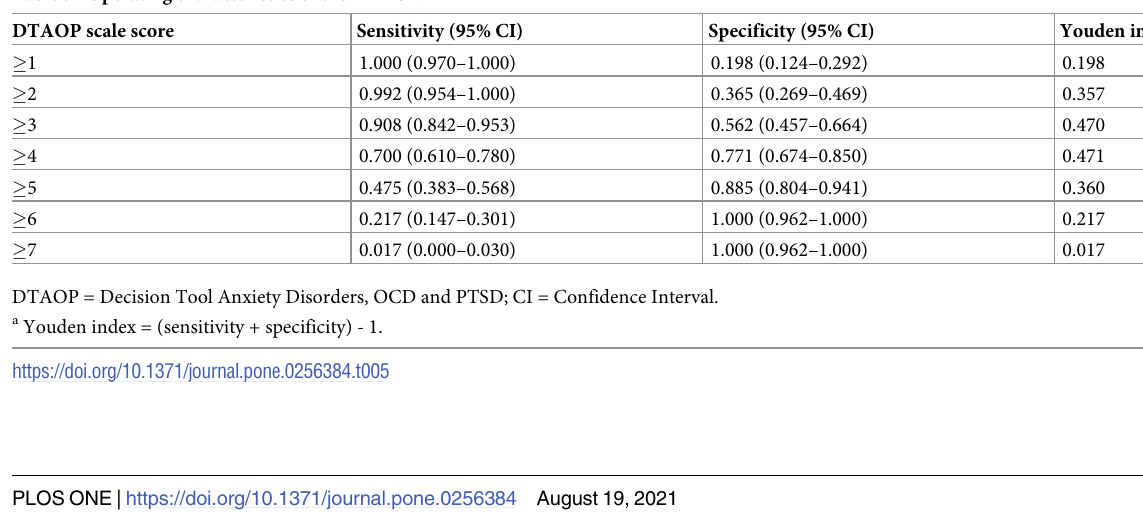
Table 5. Operating characteristics of the